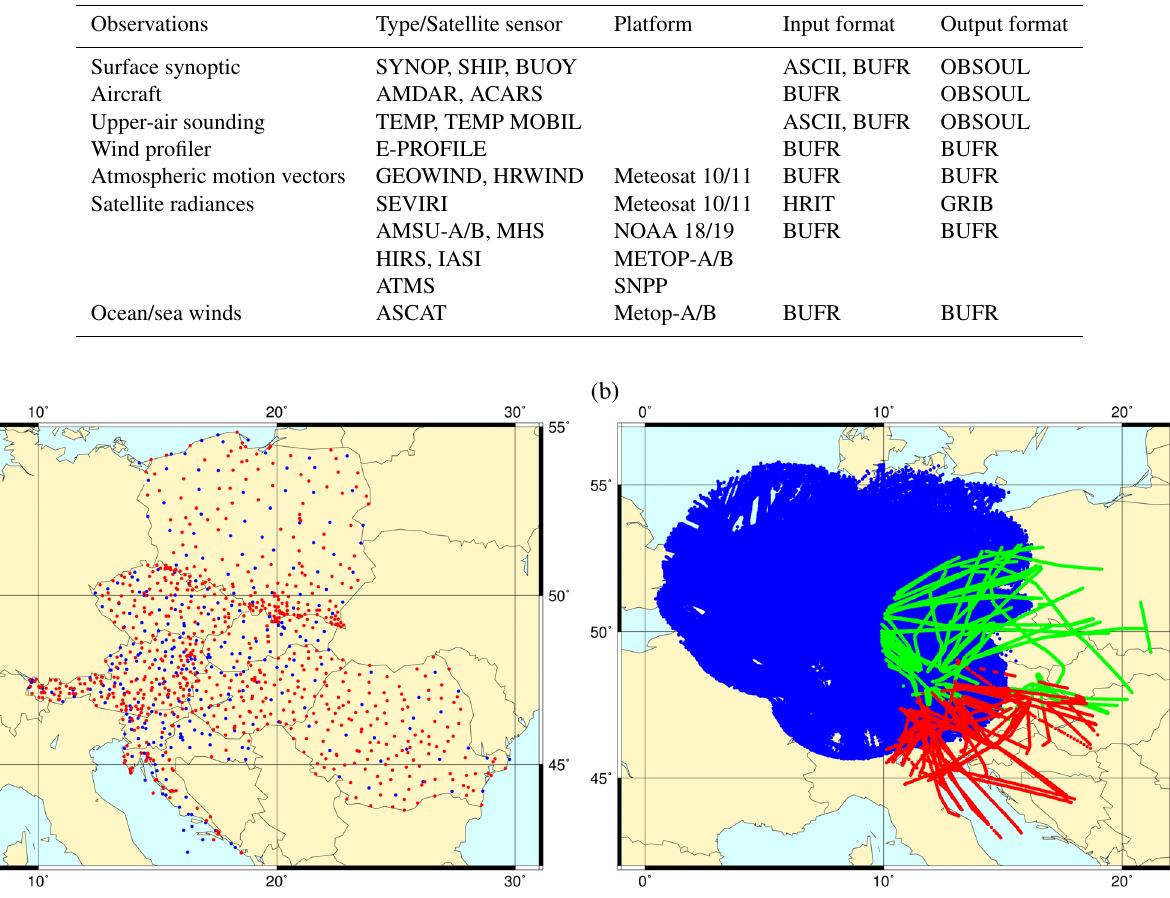
Figure 3. The geographical distribution of (a) surface observations available in the GTS (blue) and of denser national observations (red) and (b) high-resolution aircraft Mode-S EHS data from KNMI (blue) and Mode-S MRAR data from Slovenia (red) and Czech Republic (green).